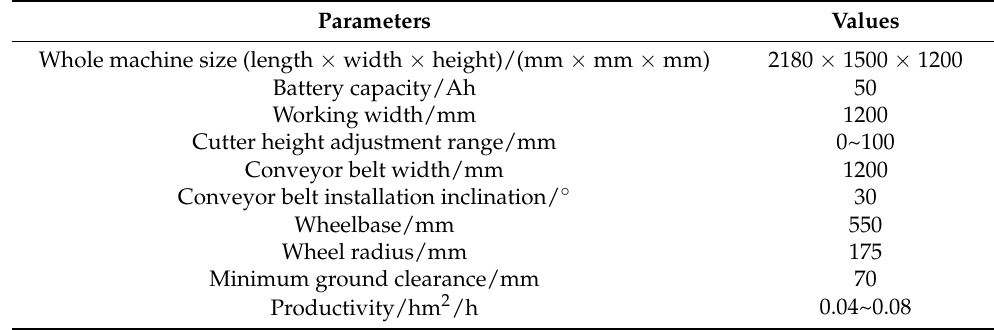
Table 1. Technical and structural specifications for the 4UM-120D electric leafy vegetable harvester.